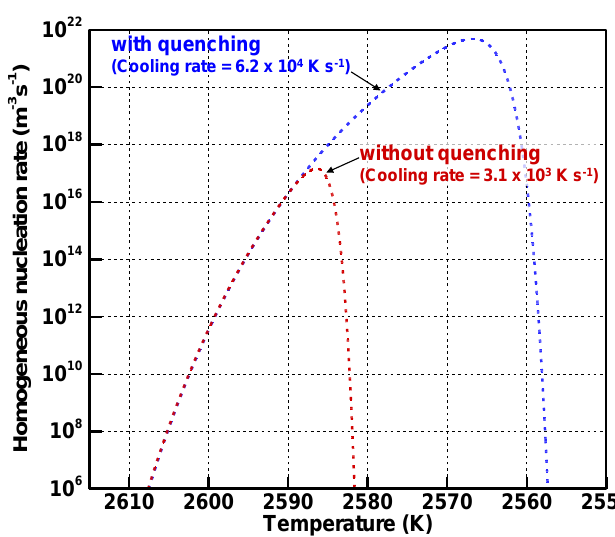
Figure 9. Evolutions of homogeneous nucleation rates.